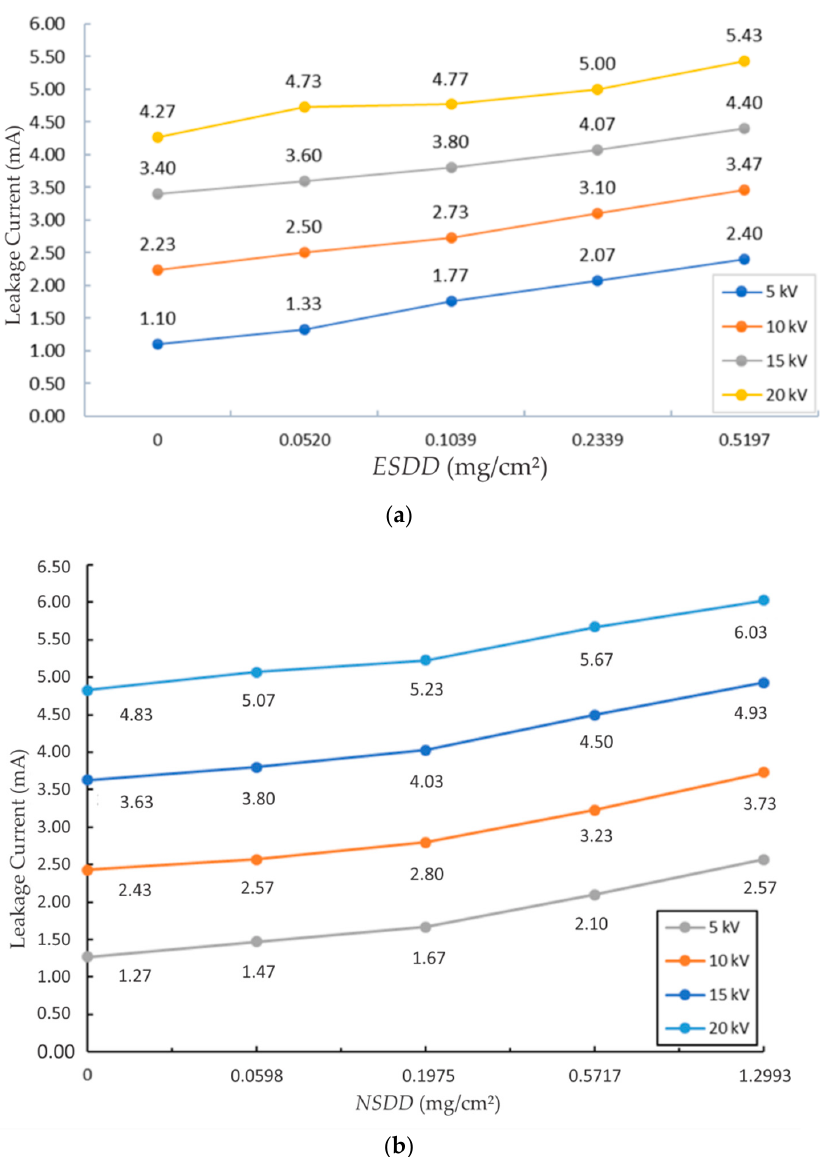
Figure 20. Effect of ESDD and NSDD variations on insulator leakage current with ( a ) salt contaminant and ( b ) fly ash contaminant.